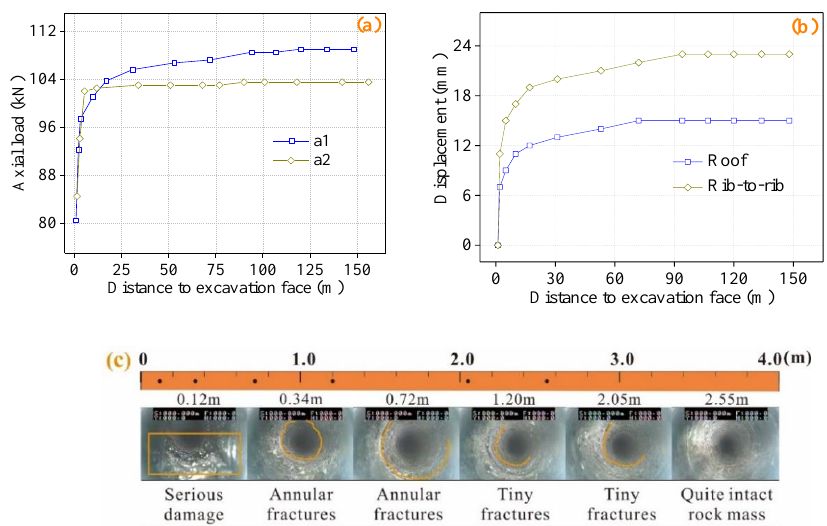
Figure 16. Results of the roadway monitoring: ( a ) axial load of flexible bolts, ( b ) surface displacement in the roadway, and ( c ) borehole camera images and corresponding analysis.